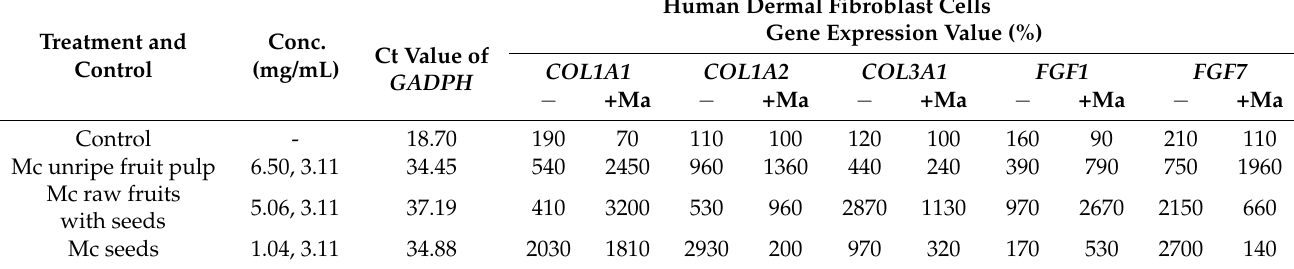
Table 3. Comparative values of stimulatory expression with and without Morus alba (Ma) protein extracts added to Morinda citrifolia (Mc) parts contains α -EG and pinoresinol; these mixtures were expected to yield higher expression